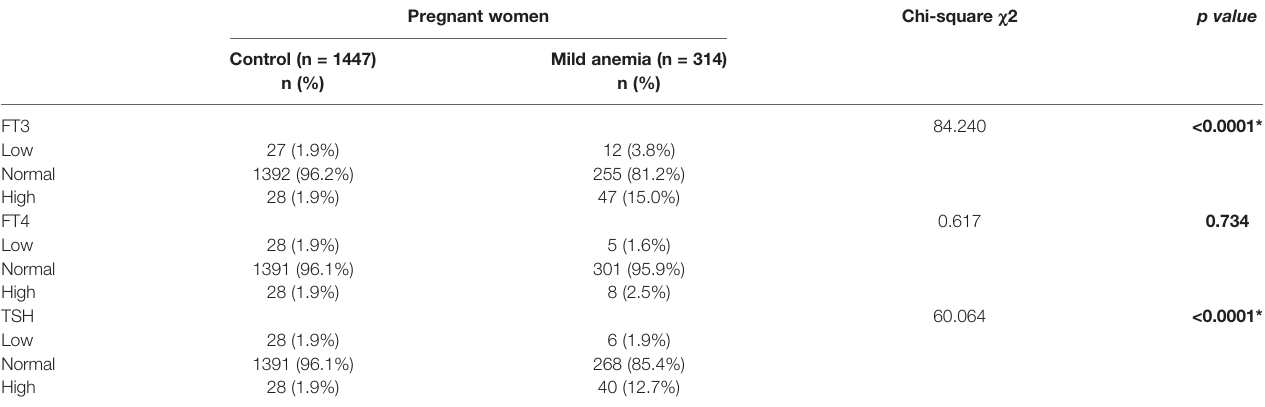
TABLE 3 | Comparison of thyroid functions abnormal between pregnant women with mild anemia and control group.